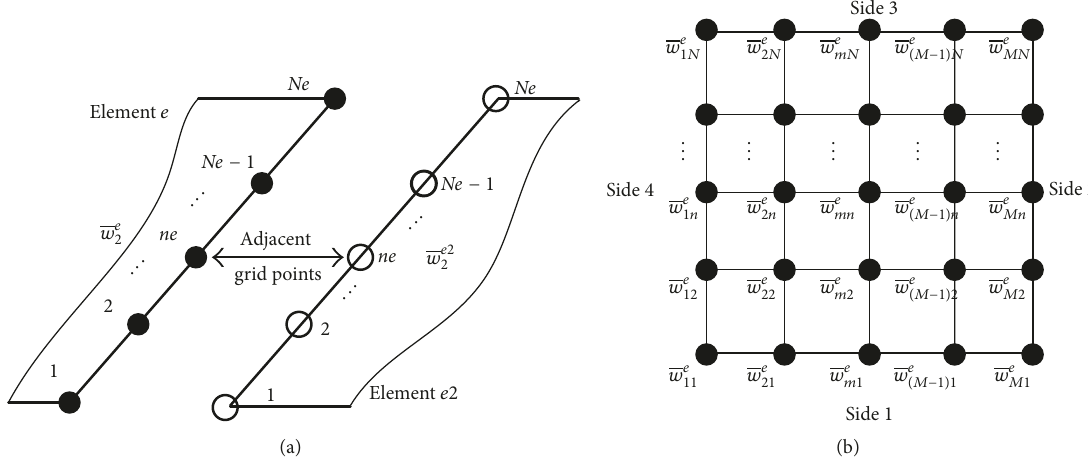
Figure 2: (a) The relative positions of the coupling grid points on the adjacent sides of two elements and (b) the distributions of the grid